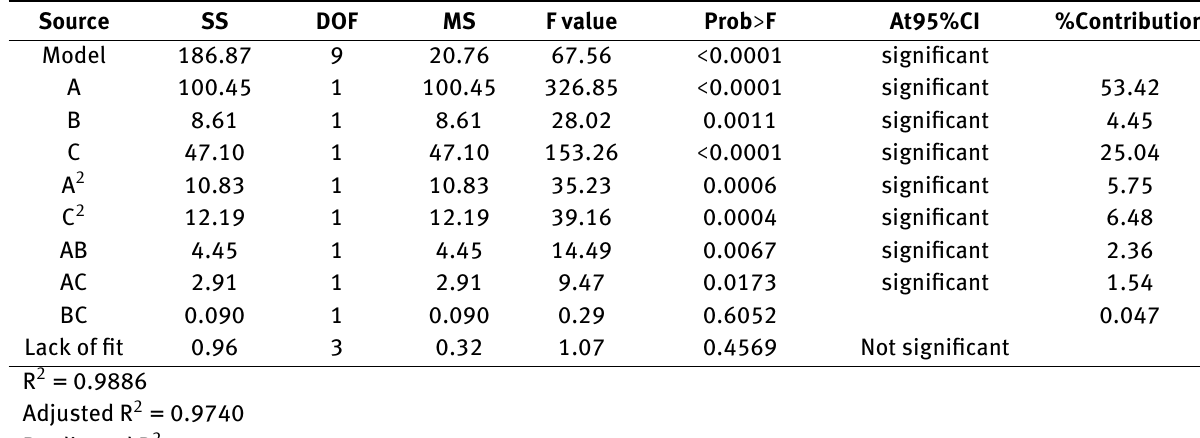
Table 4: ANOVA for response surface quadratic model for MRR